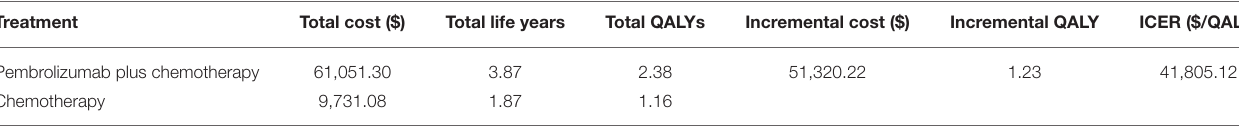
TABLE 2 | The cost and outcome results of the cost-effectiveness